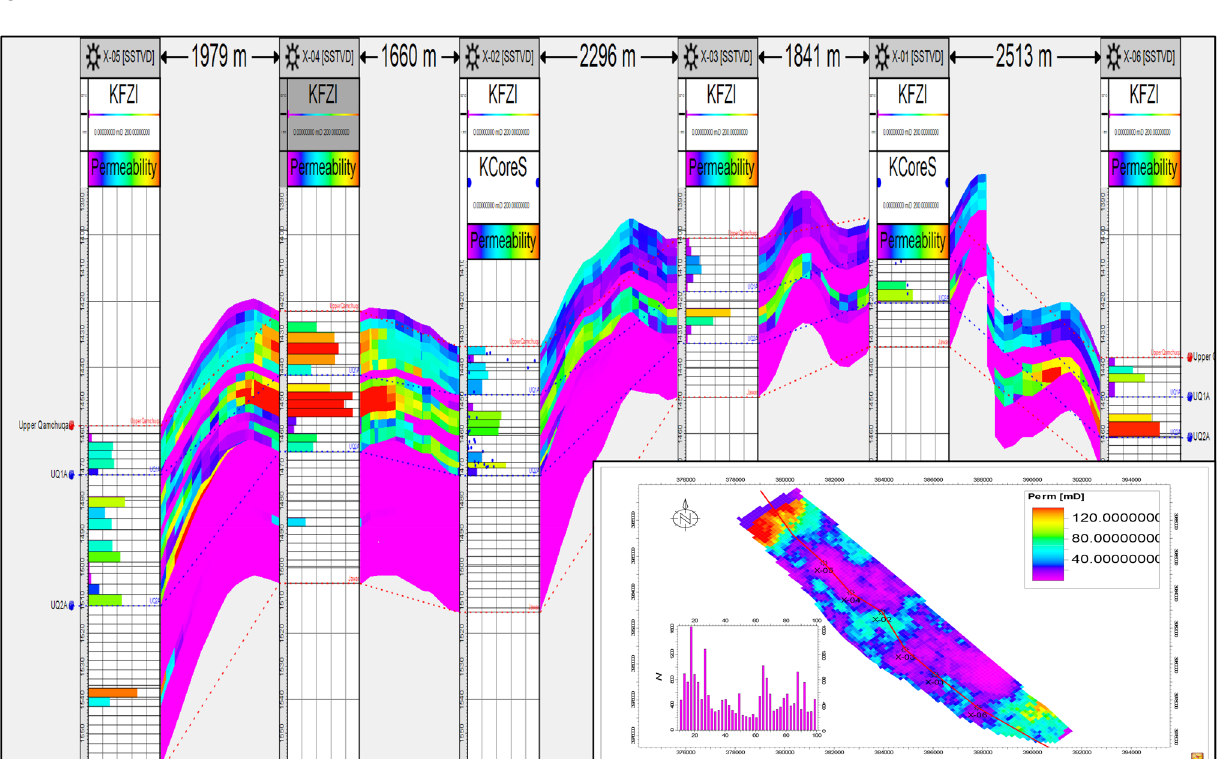
Fig. 6 Matrix permeability